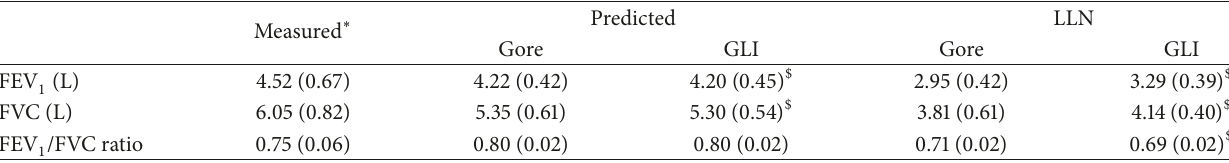
Table 1: Measured and predicted lung function values using Gore and GLI equations. Participants are never-smokers with no history of doctor-confirmed asthma or lung disease. Values are means (standard deviation) ( N = 212).